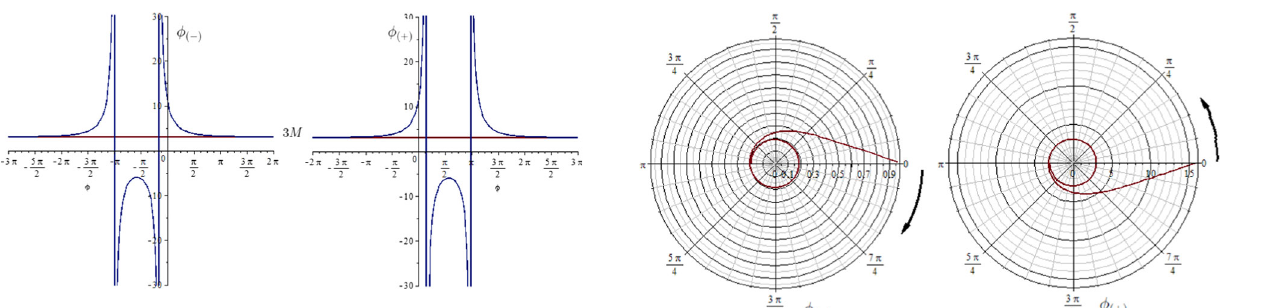
Fig. 1 The functions r ( ± ) (φ) of the spiral photon geodesics closest to the photon sphere of radius 3 M Fig. 2 The functions r